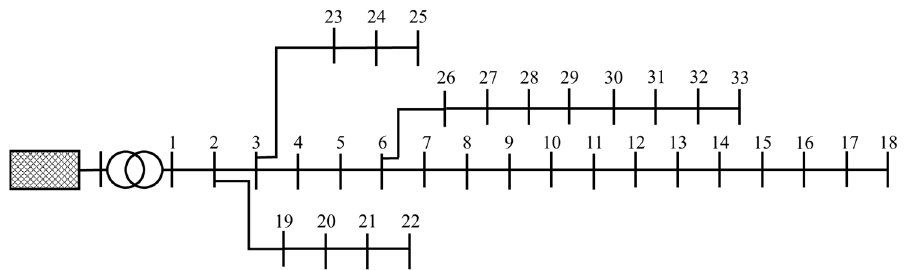
Figure 17. Single line diagram of 33-bus IEEE test network [37]. Table 6. Load data of modified 33-bus IEEE test